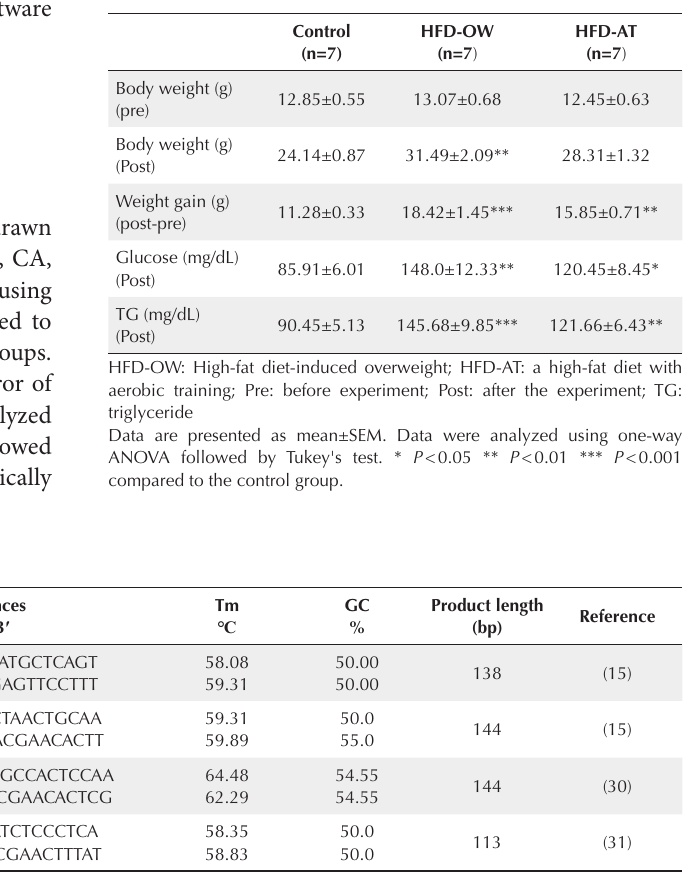
Table 2. General characteristics of the mice in different study